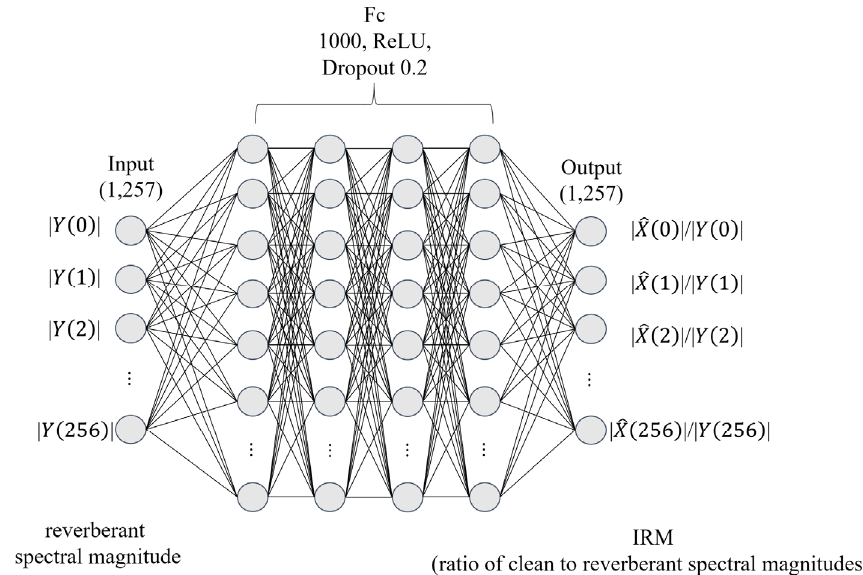
Figure 8. Block diagram of dereverberation model.